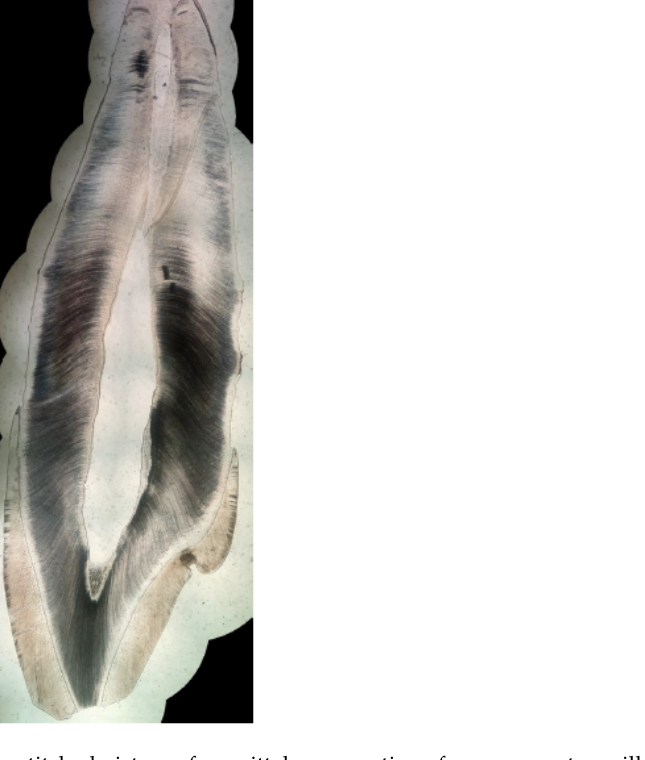
Figure 7. A third example of high-resolution stitched picture of a sagittal cross-section of a permanent maxillary central incisor